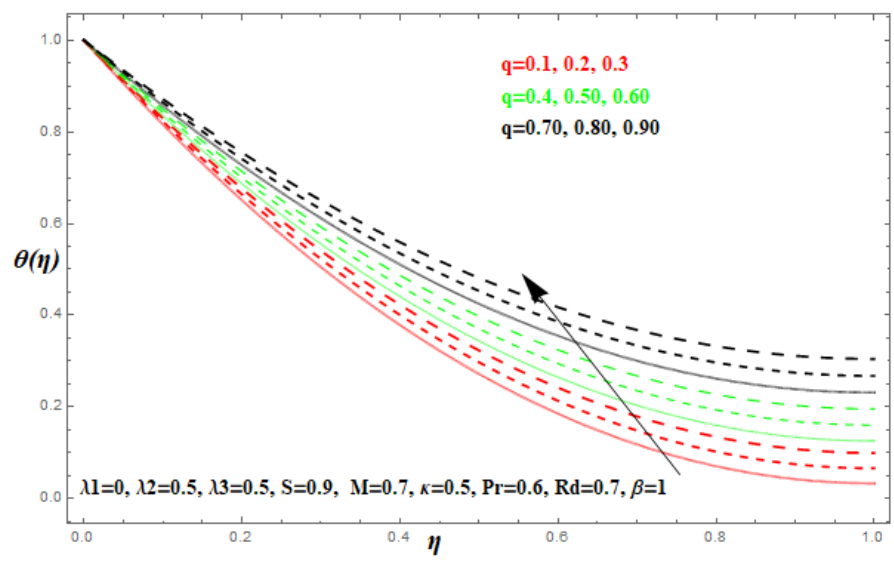
Figure 10. Changes in temperature gradient θ ( η ) for diverse measures of q .